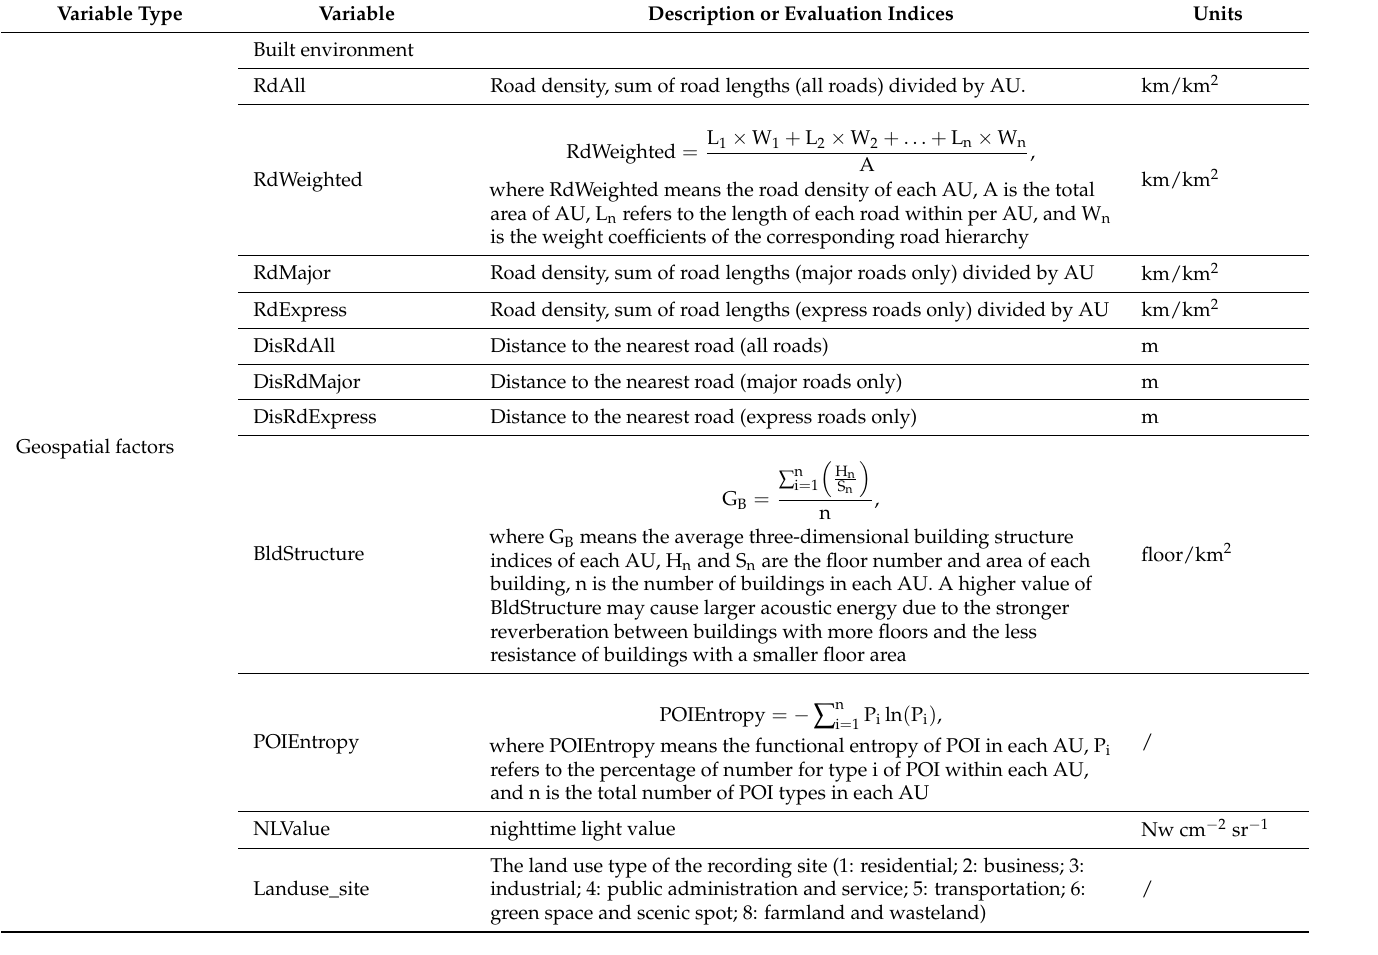
Table 1. Potential explanatory